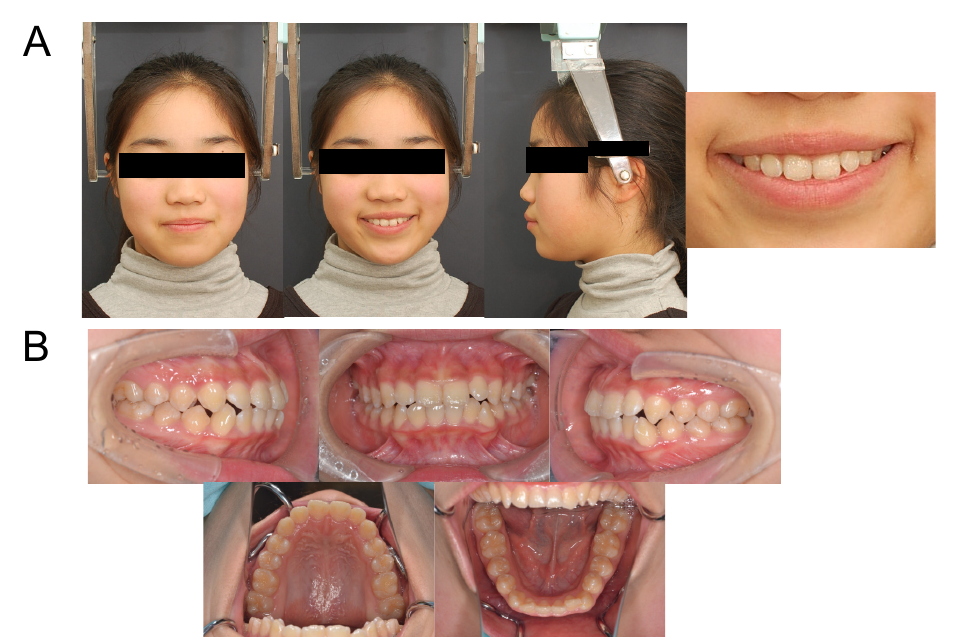
Figure 14. Superimposed images of Case 3 Overall (SN plane, reference point S) ( A ) Maxilla (palatal plane, reference point ANS) and mandible (mandibular marginal plane, reference point Me) ( B ).